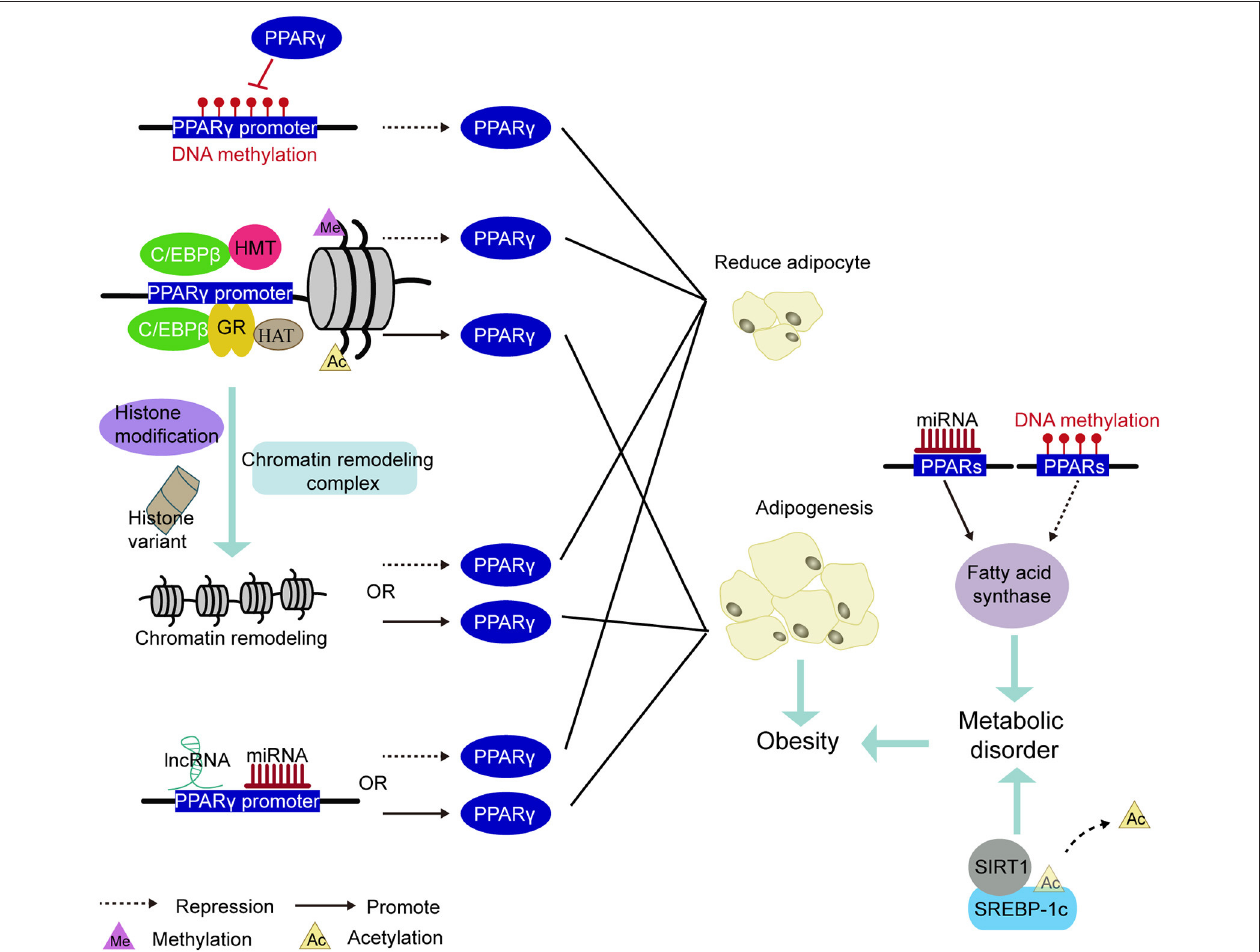
FIGURE 5 | PPARs be involved in the mechanism of epigenetic modification leading to obesity. Methylation of the PPAR γ promoter region inhibited PPAR γ expression to decrease adipogenesis. The pioneering transcription factor (e.g., C/EBP β or GR) recruit histone acetyltransferases or histone methyltransferases in the vicinity of the PPAR γ promoter and cause histone methylation or acetylation, thereby regulating PPAR γ expression. Under various factors such as histone modifications, histone variants, and chromatin remodeling complexes, the chromatin remodeling in the PPAR γ promoter induces changes in the expression of PPAR γ . The miRNA and lncRNA acting on the PPAR γ promoter region also govern the expression of PPAR γ . Inhibited expression of PPAR γ reduces the production of adiposity. Conversely, promoting the expression of PPAR γ increases in adipogenesis and leads to obesity. In addition, methylation and miRNA modification of the PPARs promoter region regulates the expression of fatty acid synthase and participate in lipid metabolism. Deacetylation of the transcription factor SREBP-1c is some other important way in regulating lipid metabolism. Disorders of lipid metabolism can also induce